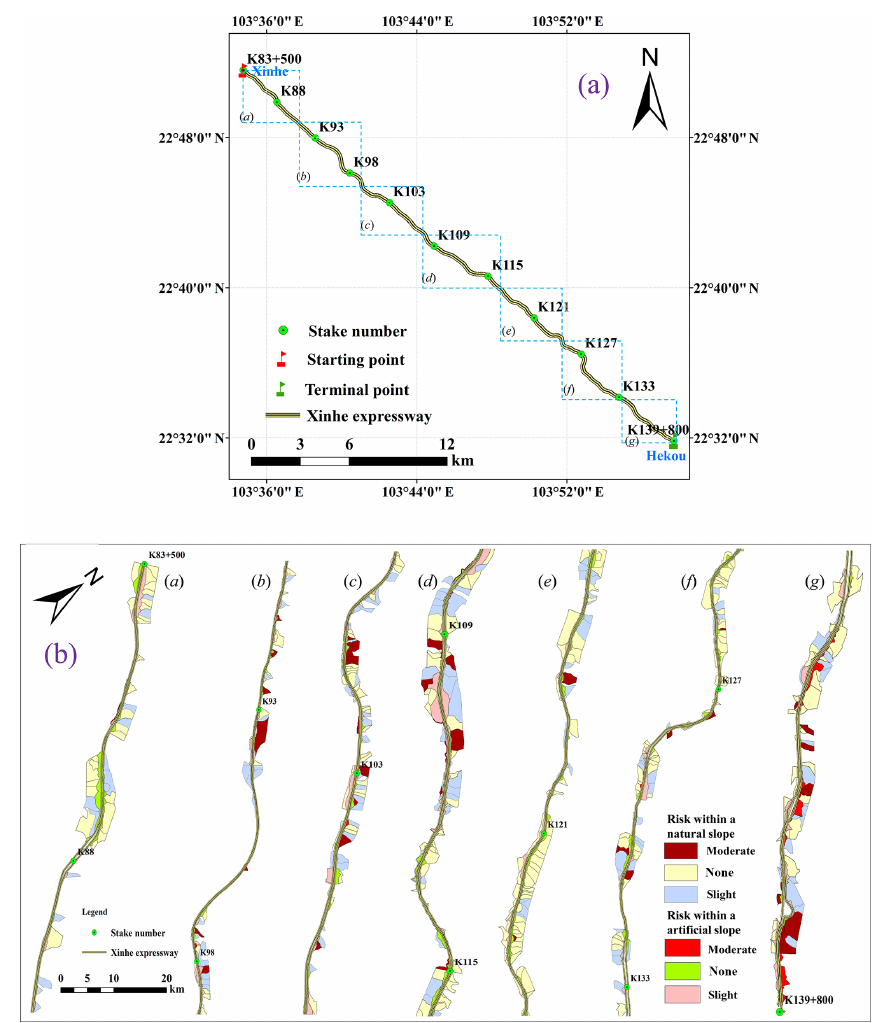
Figure 16. (a, b) Risk analysis of soil and water loss for the 1-year return period rainfall amount.